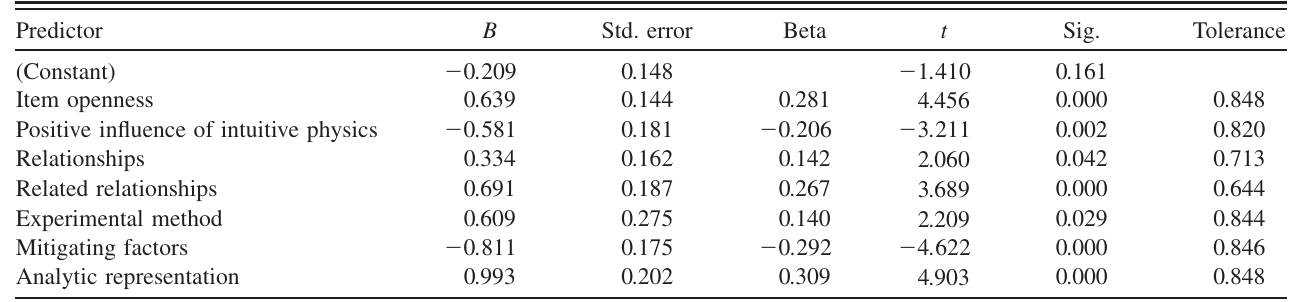
TABLE VI. Predictor statistics.